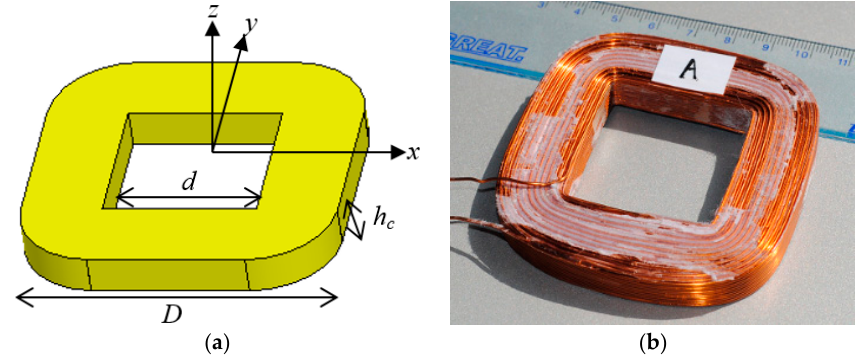
Figure 10. Model and prototype of the square coil: ( a ) model and sizes; ( b ) actual square coil. Table 1. The actual sizes of coil and the conductor gauge.